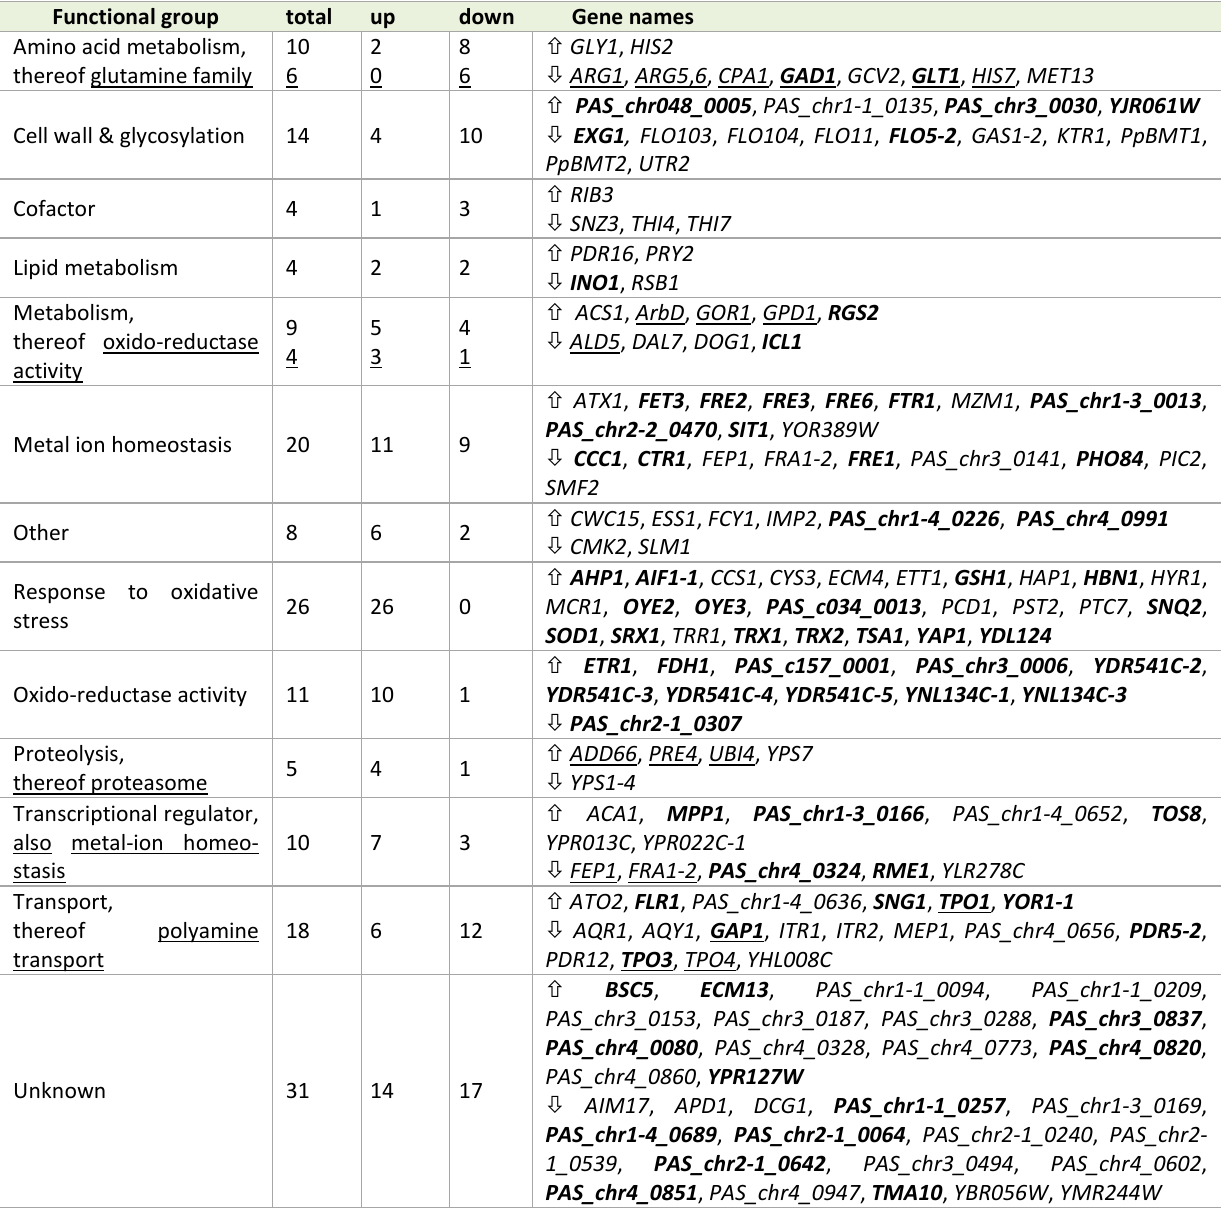
TABLE 1. Differentially regulated genes upon YAP1 overexpression in P. pastoris secreting trypsinogen (trpYAP1/trp). Functional